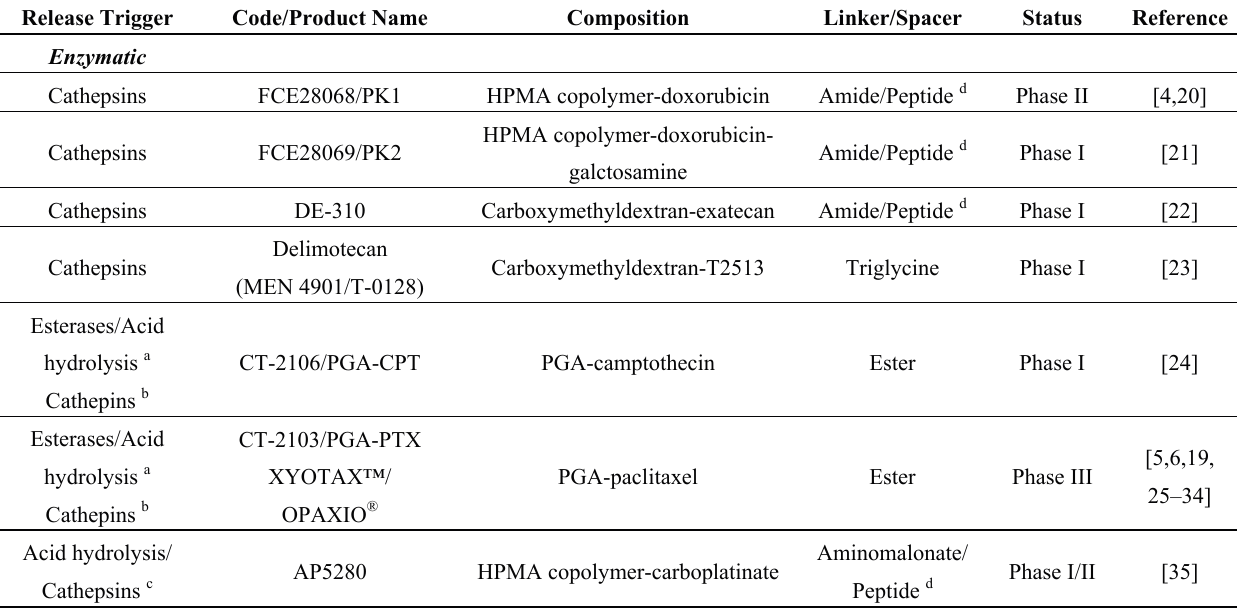
Table 1. Current clinical status of polymer-drug conjugates (PDCs) and types of release triggers. Release